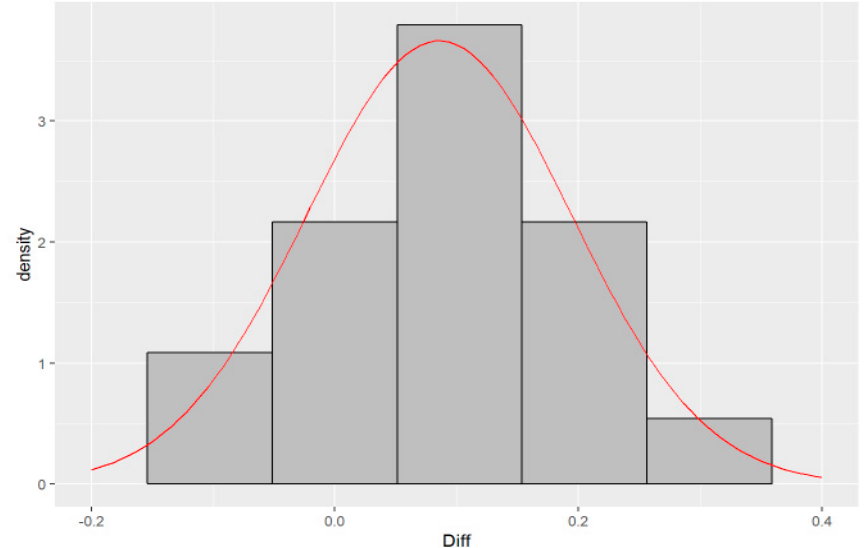
Figure 5. Histogram of differences of measurements with a density of normal distribution.